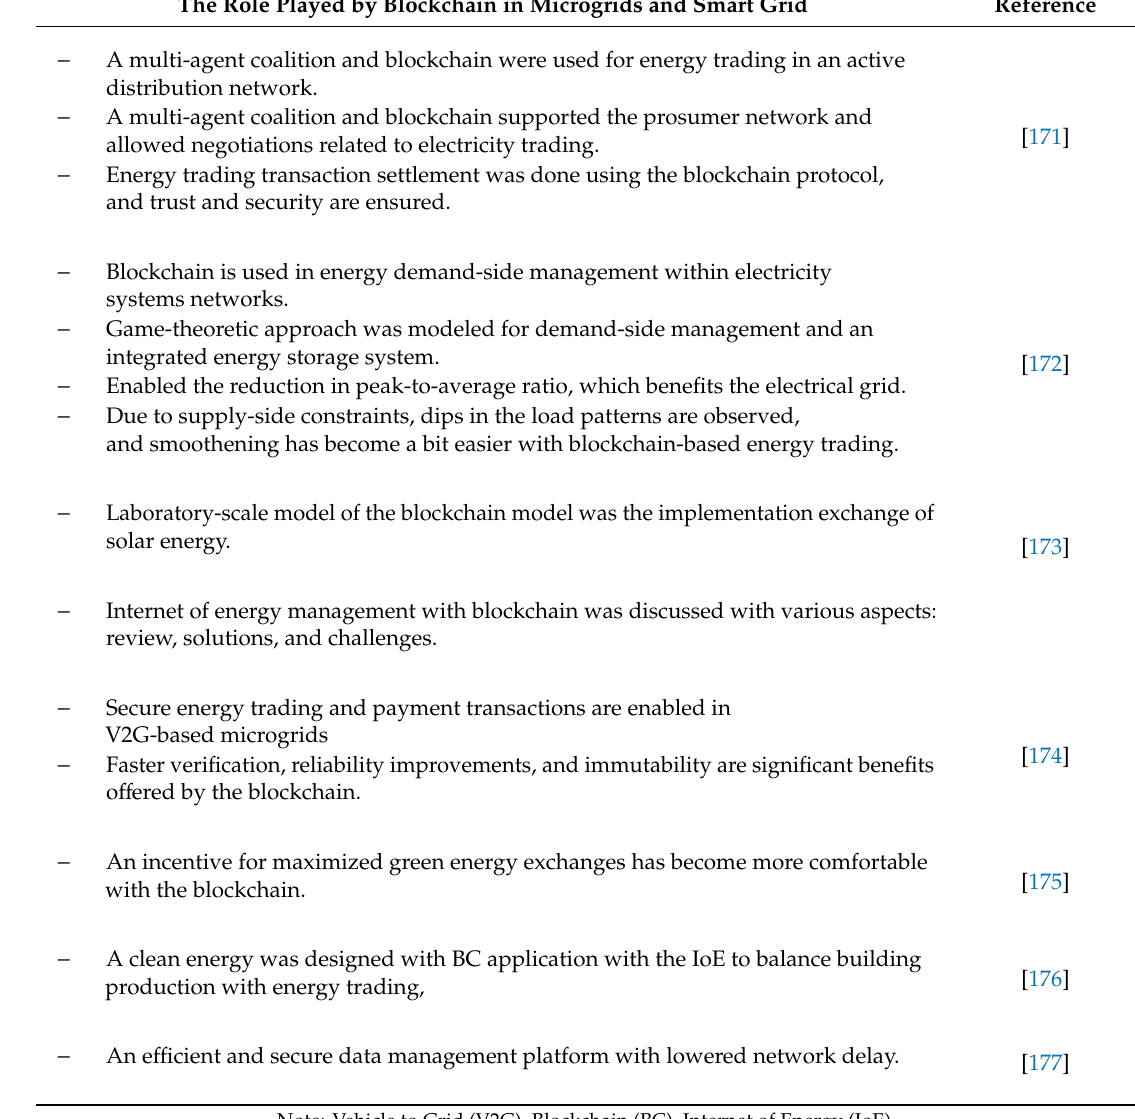
Table 4. Role of blockchain in the microgrids and smart